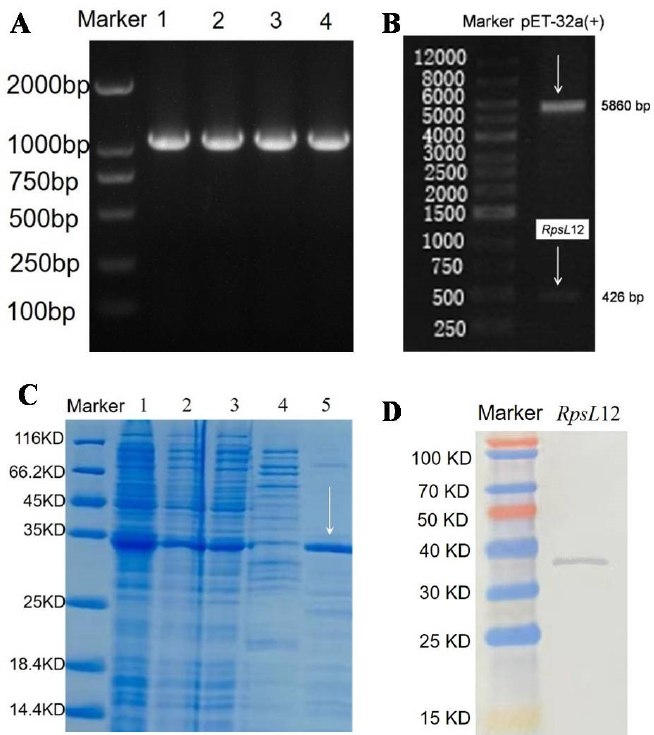
Figure 3. (A) Agarose gel electrophoresis results of (A) RpsL 12 gene (1138 bp, containing RpsL 12 gene 426 bp and T7 primer 712bp) (lane 1-4, PCR products) and (B) express vector pET32a- RpsL 12 after enzyme digestion. (C) SDS-PAGE results of RpsL 12 (34 kDa) (lane 1, bacterial whole protein; lane 2, supernatant; lane 3, inclusion body; lane 4, collected rinse solution during supernatant purification; lane 5, purified supernatant). (D) Western blotting analysis of RpsL 12.